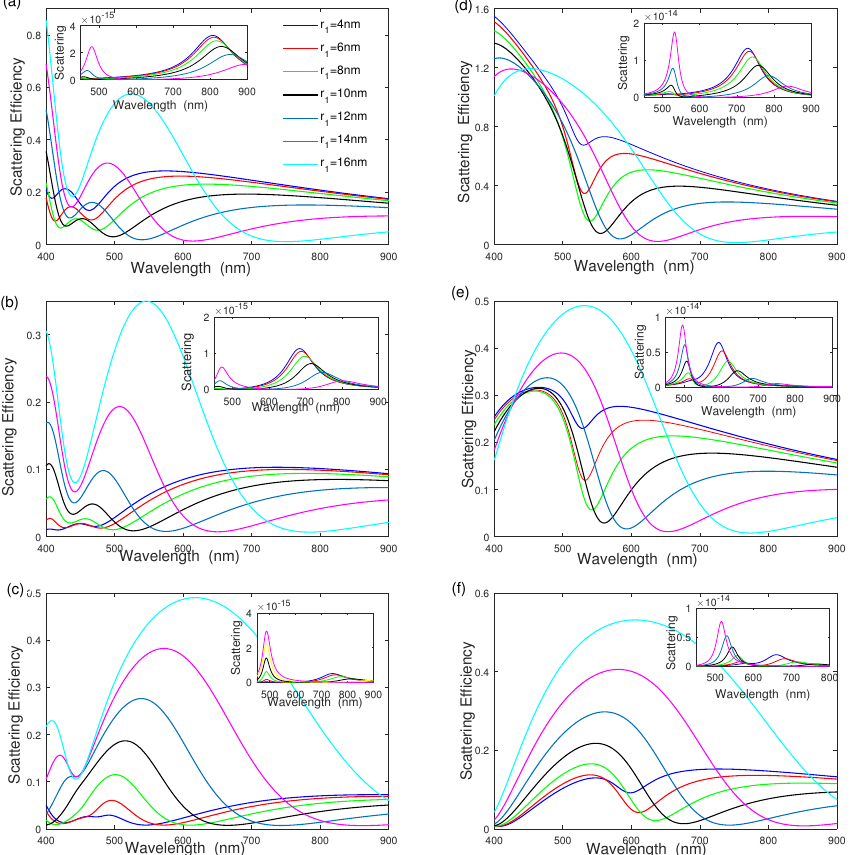
Figure 3. The effect of inner core radius r 1 on scattering efficiency and scattering. ( a – c ) Silver– dielectric–gold nanoshell with [ ε 2 , ε 4 ] = [ 4.0,2.0 ] , [ ε 2 , ε 4 ] = [ 2.0,2.0 ] , and [ ε 2 , ε 4 ] = [ 2.0,4.0 ] ; ( d – f ) gold–dielectric–silver nanoshell with [ ε 2 , ε 4 ] = [ 4.0,2.0 ] , [ ε 2 , ε 4 ] = [ 2.0,2.0 ] , and [ ε 2 , ε 4 ] = [ 2.0,4.0 ] ,